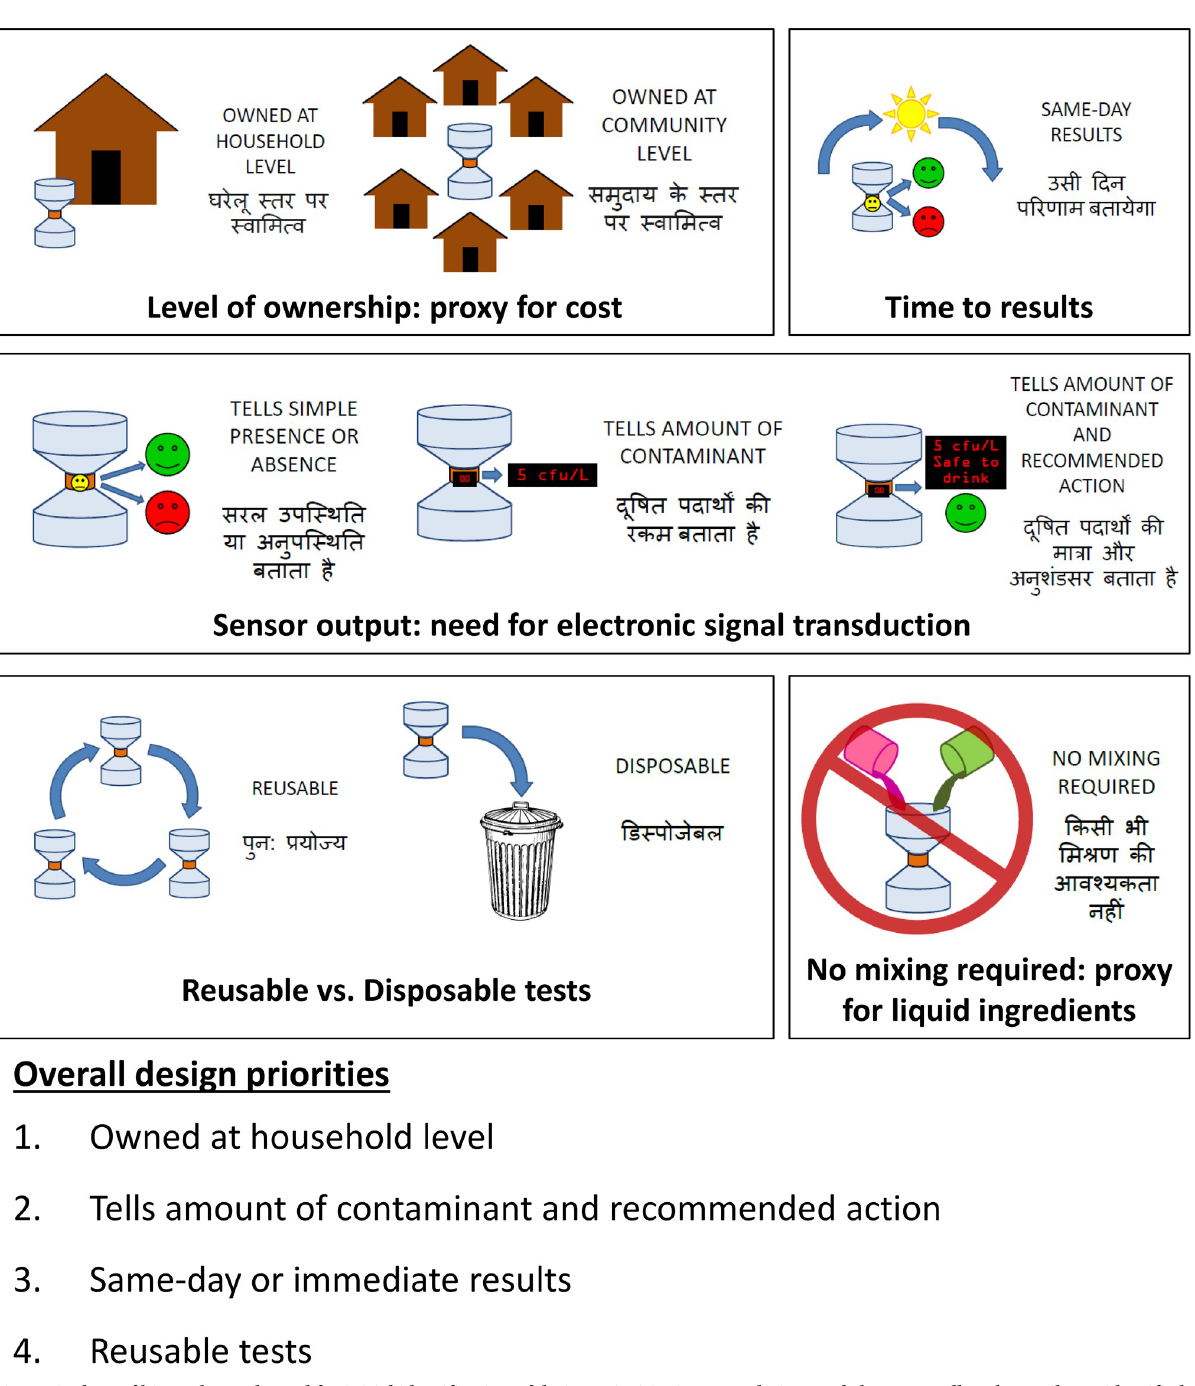
Fig 2. Final set of hierarchy cards used for initial identification of design priorities in group design workshops, as well as the attributes identified as overall design priorities from the group design workshops.